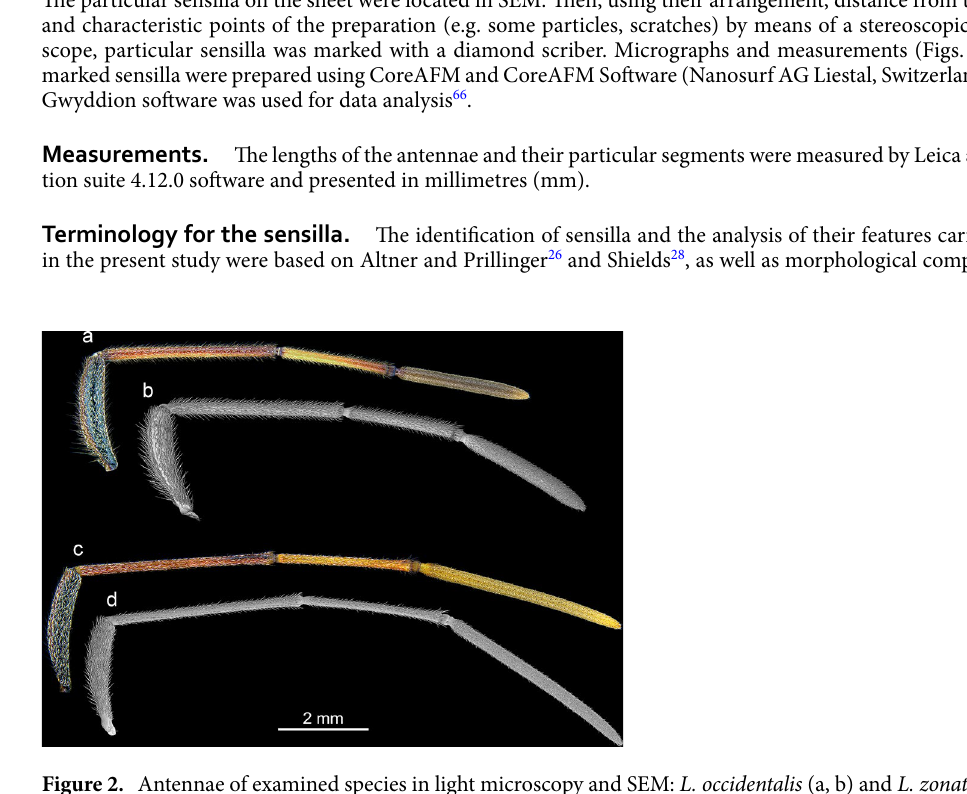
Figure 2. Antennae of examined species in light microscopy and SEM: L. occidentalis (a, b) and L. zonatus (c,